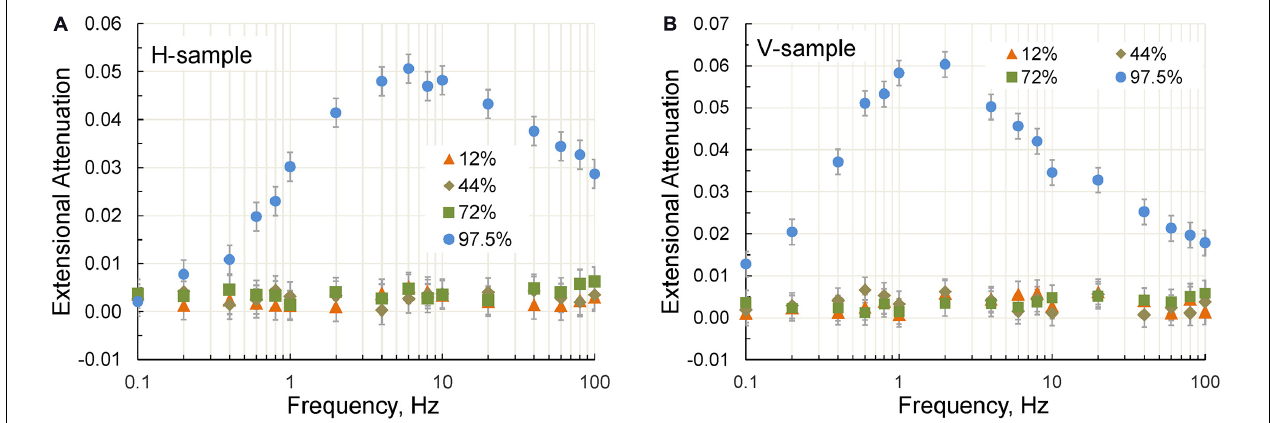
FIGURE 13 | The extensional attenuation measured on the horizontal (A) and vertical (B) samples at a confining pressure of 6 MPa and relative humidity of 12, 44, 72, and